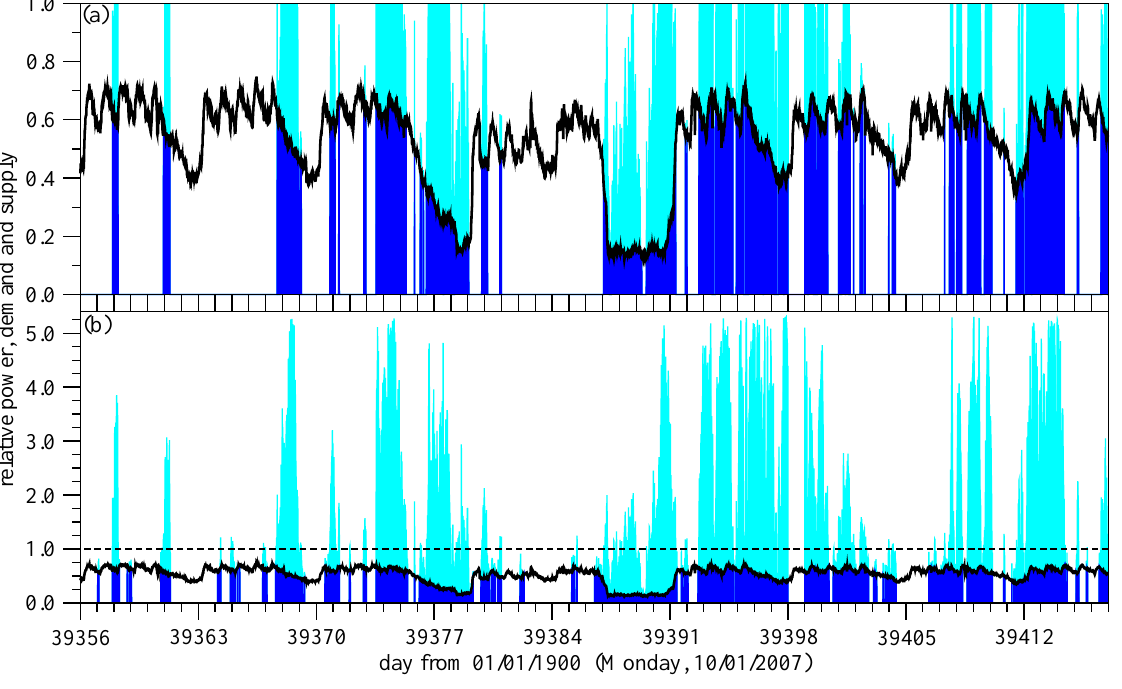
Figure 6. Matching of wind power supply (blue shading) with demand (black curve) in two full months (October–November, 2007) for wind power record P blue shading indicates excess wind power. (a) F = 1 . 0 , (b) F = 2 . 0 [see Equation (3)]. The vertical scale is extended to illustrate excess